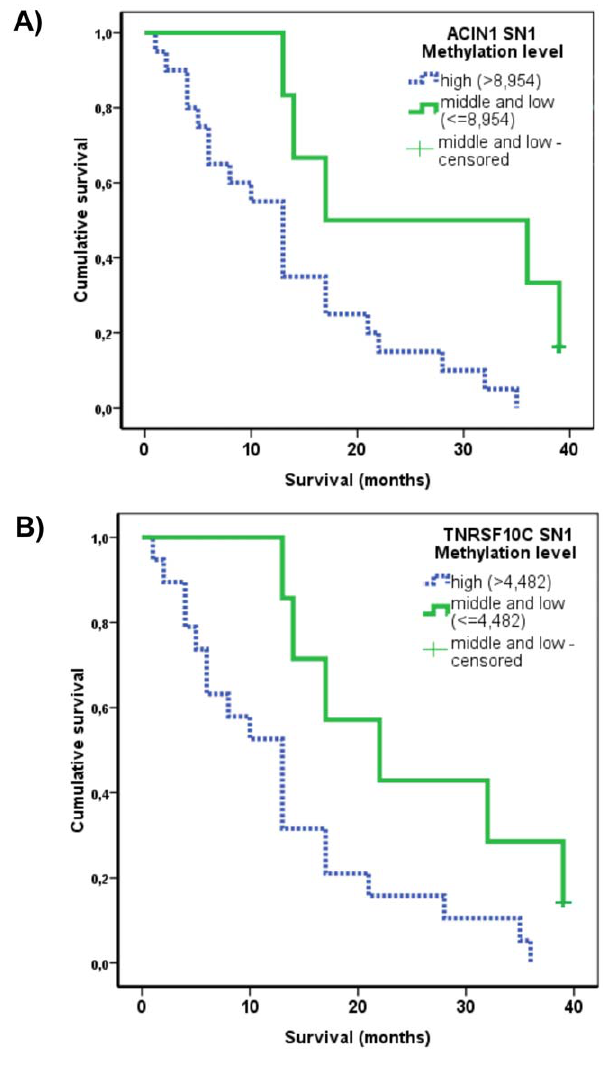
Figure 2. Kaplan-Meier survival estimates of overall survival for methylation levels in peripheral blood of cancer patients. ACIN1 SN1 (A), log rank=0.012 and TNFRSF10C SN1 (B), log- rank=0.023. doi:10.1371/journal.pone.0037509.g002 PLoS ONE |